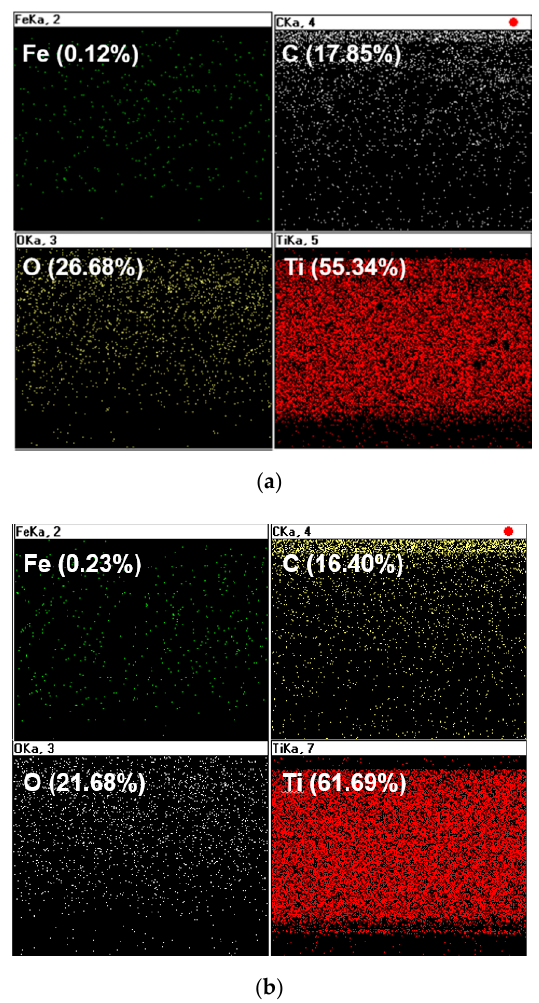
Figure 10. EDS graphs of the workpiece before and after the magnetic abrasive finishing process (under optimal conditions: 1 μ m, 3 mm, 2000 rpm, 300 s).